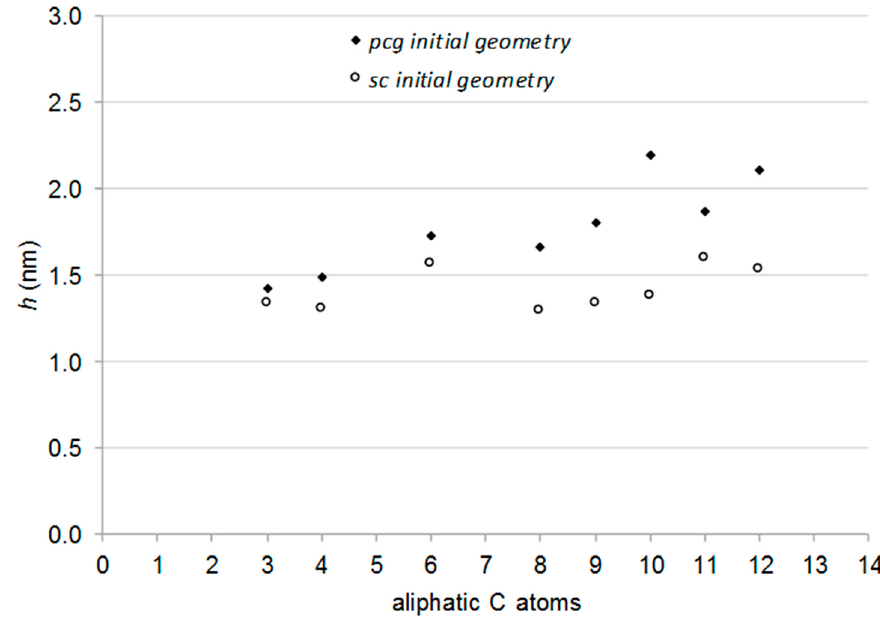
Figure 8. AATEABs maximum length versus carbons number of the AATEABs aliphatic chain using the DFT optimized structures.